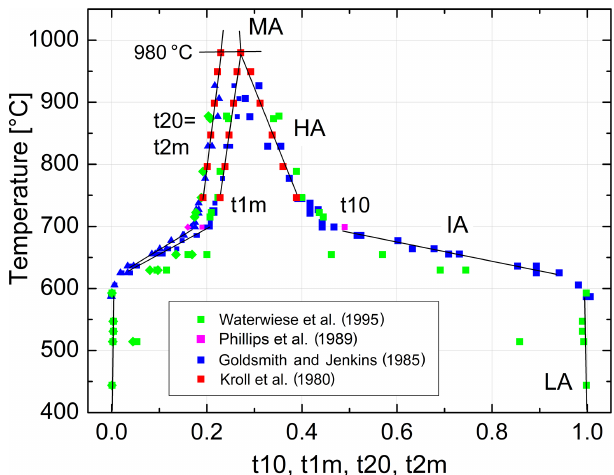
Figure 10. Variation in the individual Al site occupancies in Na-feldspar in equilibrium with temperature at ambient pressure. Straight lines are drawn to guide the eye. t 1 0 = Al / (Al + Si) in the T 1 0 tetrahedral site and similarly for t 1 m and t 2 0 = t 2